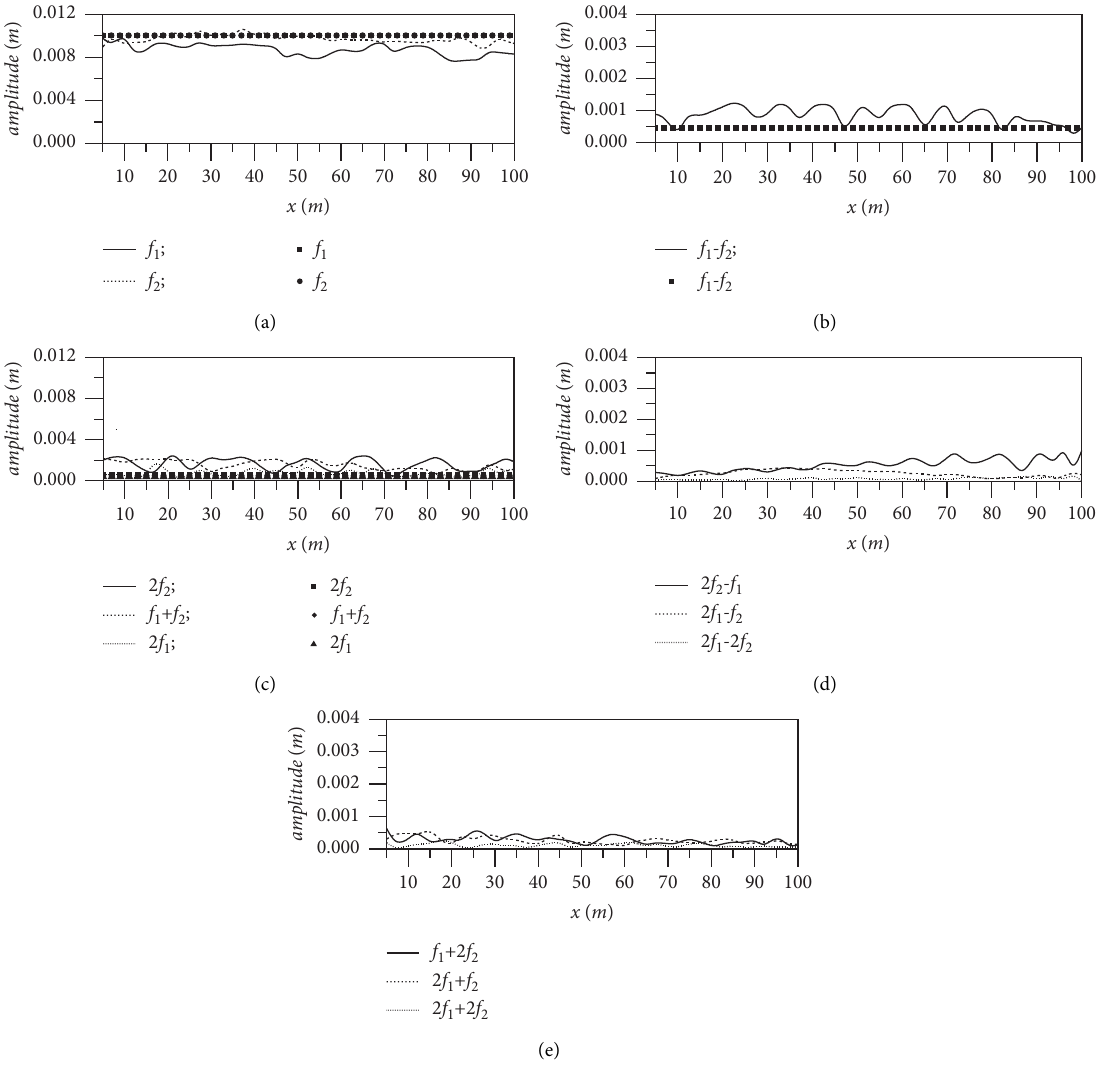
Figure 4: Comparisons of the spatial variation of amplitudes of each frequency component between calculation and theoretical results for case C1. , , calculation solutions; , , theoretical